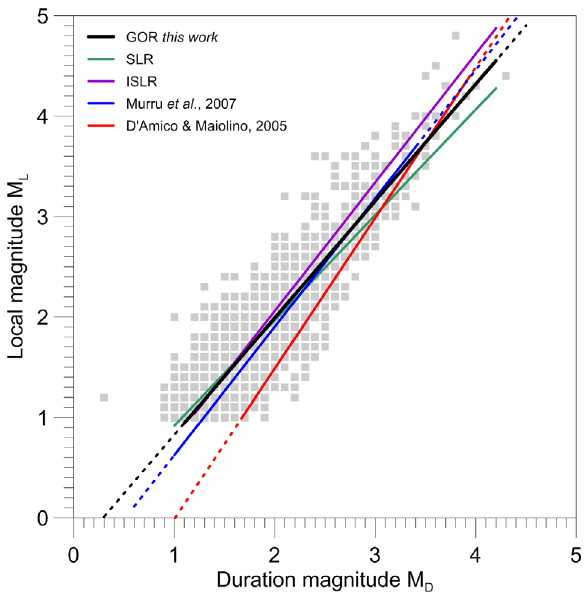
and L -M couples. For compari- D L